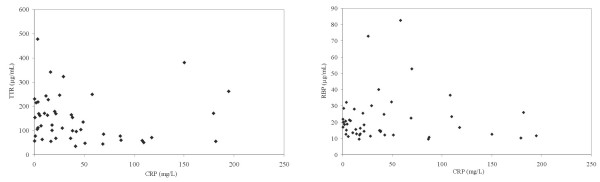
Correlation between levels of CRP and TTR in serum (p = 0.08) and between levels of CRP and RBP in ascitic fluid (p < 0.05).